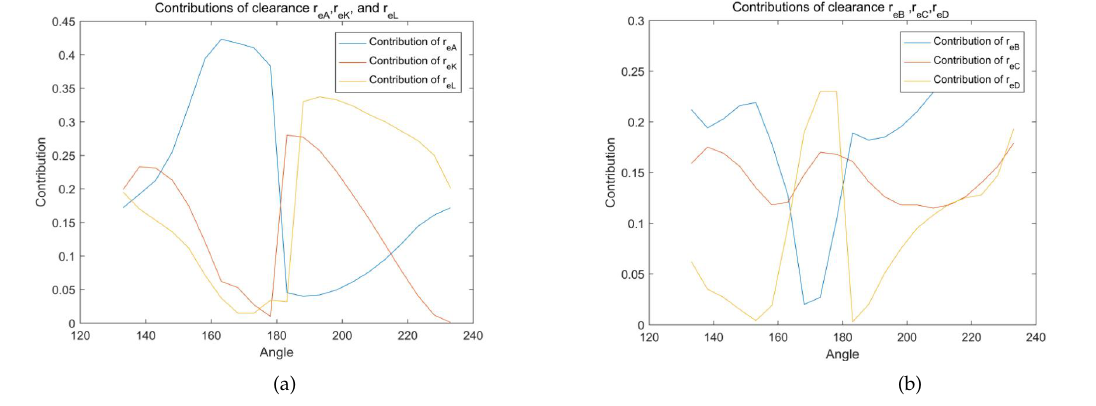
Figure 9. ( a ) The contributions of r eA , r eB , and r eC ; ( b ) The contributions of r eD , r eK , and r eL .